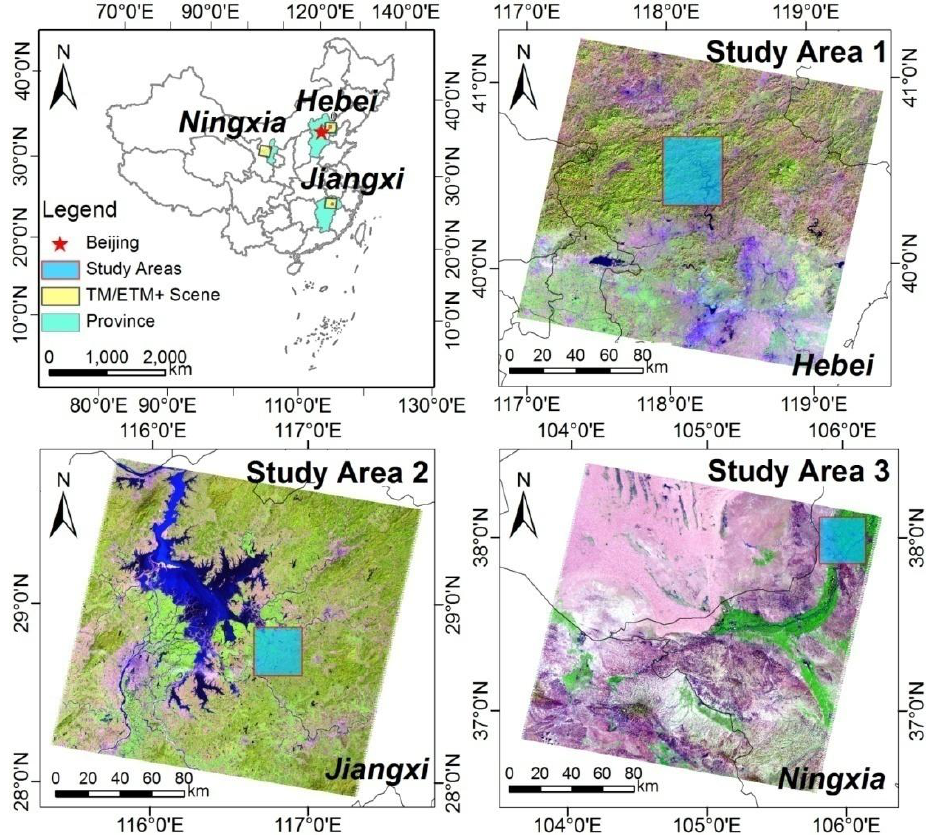
Figure 1. Locations of the three study areas in China. Study Area 1 includes the Panjiakou Reservoir in Hebei Province. Study Area 2 includes Yugan County in Jiangxi